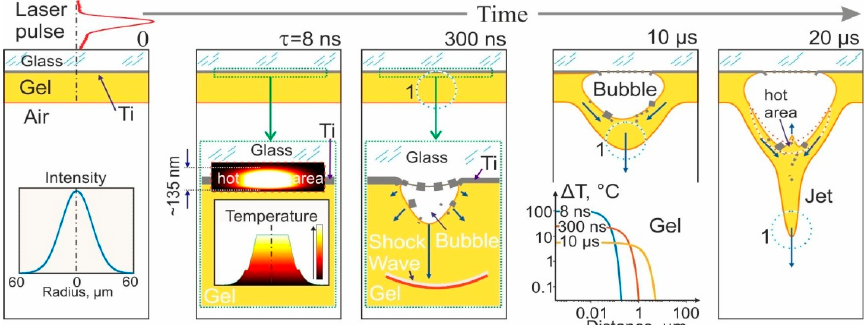
Figure 4. Main stages of gel jet formation during laser pulsed heating of the Ti film of the donor slide after an 8 ns laser pulse. By the end of the pulse with τ = 8 ns, a thin (total ~135 nm) layer of glass and gel is heated simultaneously with the Ti film up to the temperature ≥ T b /2 ≈ 1650 ◦ C. By t = 300 ns, a gas-vapor bubble is formed near the Ti film and begins to expand. Ti nanoparticles are visible in the region of the laser spot, inside the bubble, and in the thin gel layer on the surface of the bubble. A shock wave leaves the area of laser impact (not to scale). By t = 10 µ s, a gel jet begins to form. The inset shows the temperature jump ∆ T distribution in the gel in the paraxial region at different times. The distance from the bottom wall of the bubble is indicated. By t = 20 µ s, the jet elongates, and a counter jet is formed. The heated liquid layer is mainly concentrated on the surface adjacent to the bubble (the area is highlighted by the red dotted curve). The blue dotted curve 1 marks the region of the jet from which a microdrop is subsequently formed, which transfers to the acceptor surface.